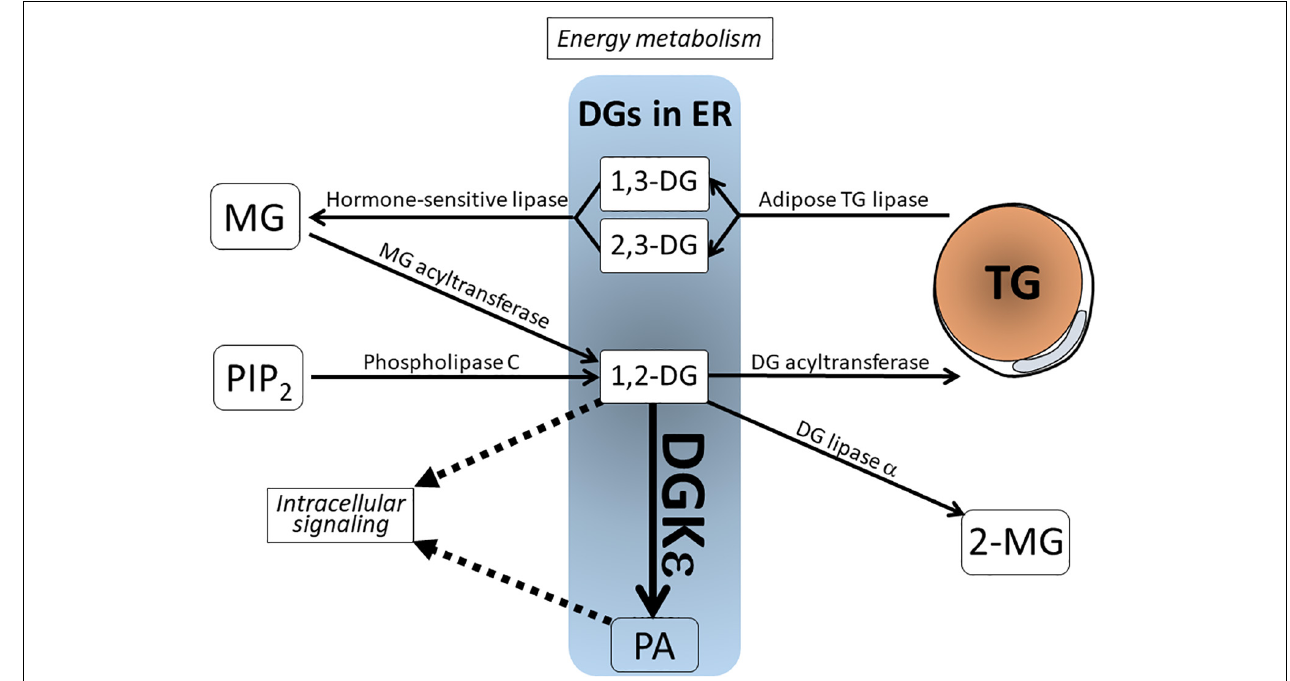
FIGURE 1 | Schematic view of the DG in lipid metabolism and signal transduction. DGs in the endoplasmic reticulum (ER) include various species from distinct sources. 1,2-DG is derived from MG by MG acyltransferase and from phospholipase C-mediated PIP 2 breakdown. 1,3-DG and 2,3-DG are lipolytic products of TG by adipose TG lipase. These DGs are not intermingled and separately metabolized. Note that 1,2-DG serves not only as an intermediate product for TG synthesis, but also as a lipidic second messenger. It is phosphorylated by the action of DGK to produce phosphatidic acid (PA). DG, diacylglycerol; DGK ε , DG kinase ε ; MG, monoacylglycerol; PA, phosphatidic acid; PIP 2 , phosphatidylinositol 4,5-bisphosphate; TG, triglyceride; 2-MG,